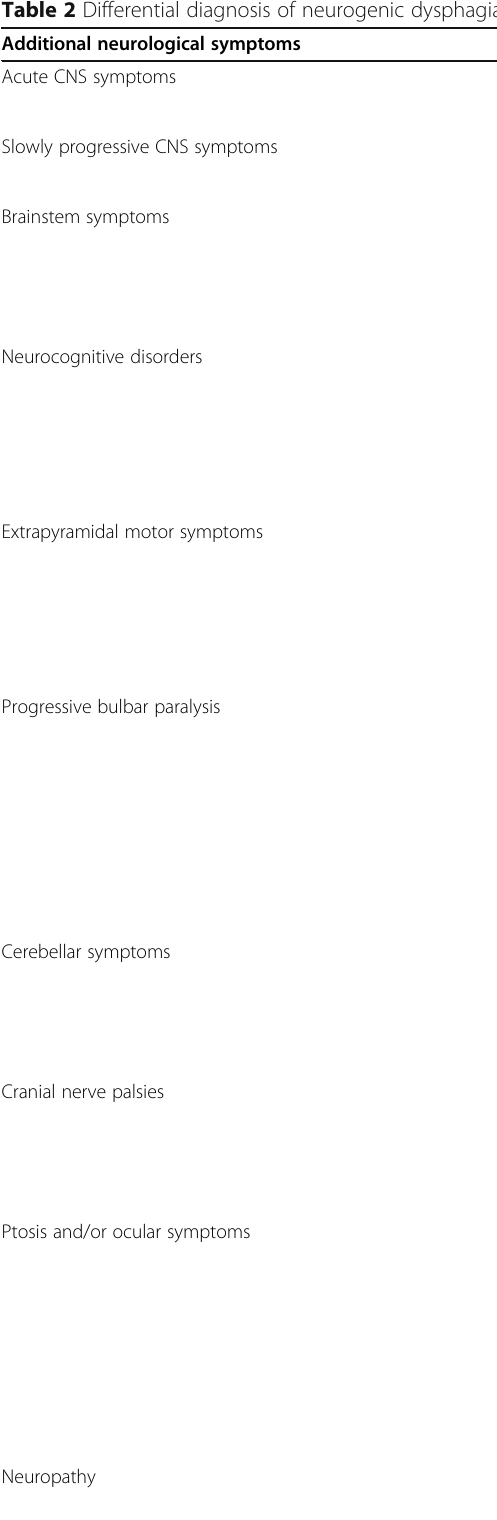
Table 2 Differential diagnosis of neurogenic dysphagia in relation to additional neurological symptoms (according to